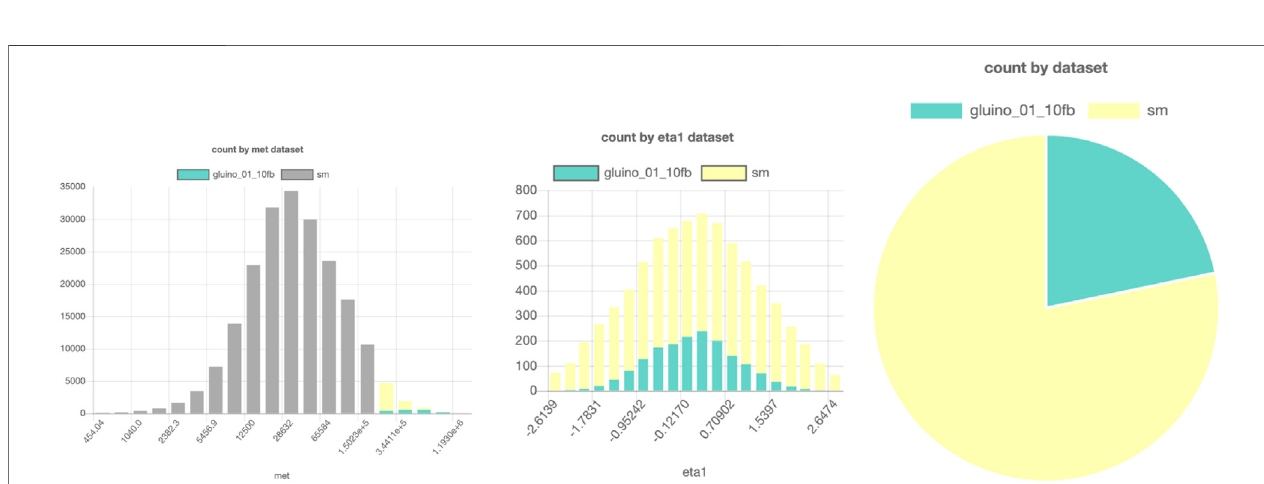
FIGURE 6 | Copy of Figure 5A in Achterberg et al. (2017). This plot has been recreated in SPOT and a screenshot is shown in Figure 5 . The fi gure is the same as the plot in the top left.